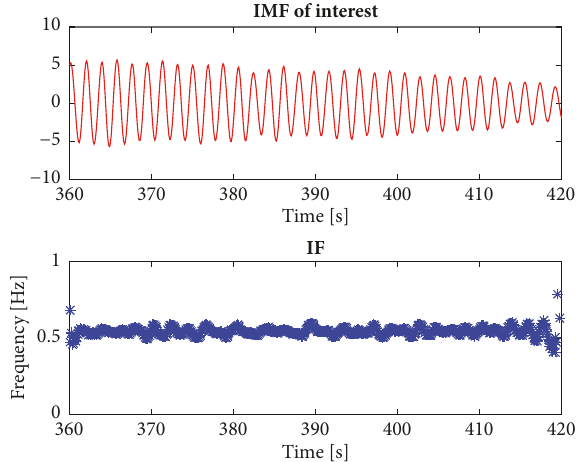
Figure 13: Tracked IMF (IMF 4) of interest linked to BWR instability and its associated instantaneous frequency (IF) around 0.5 Hz computed through the HHT.